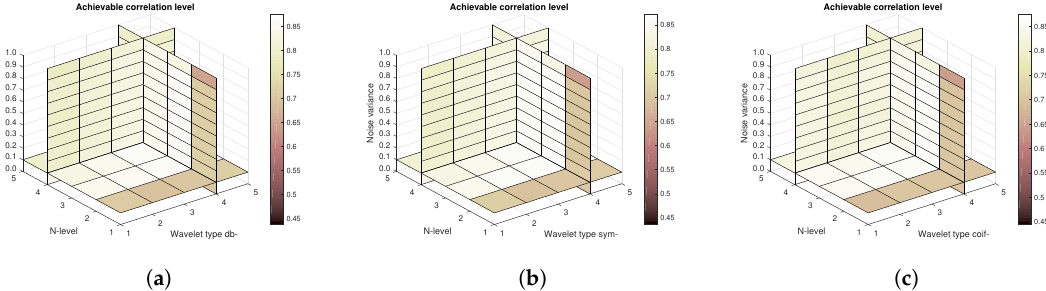
Figure 17. Achievable correlation levels in the presence of AWGN only for the CT scan from Figure 4 with use of three mother wavelet families—from left Daubechies ( a ), Symlet ( b ) and Coiflet ( c ).